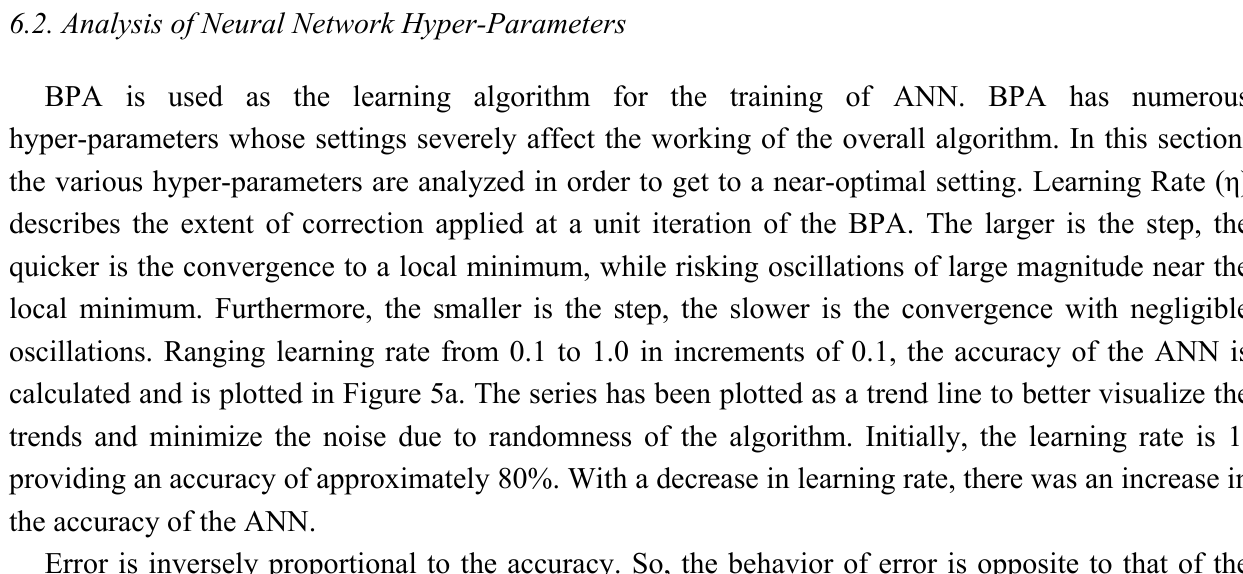
Table 1. Comparative Analysis of the proposed work with Artificial Neural Network (ANN) and Back Propagation Algorithm (BPA). Models Type Accuracy (%) Standard Deviation Validation 97.500 - Evolutionary Neural Network Testing 99.579 0.314 Validation 96.217 - Neural Network Testing 97.202